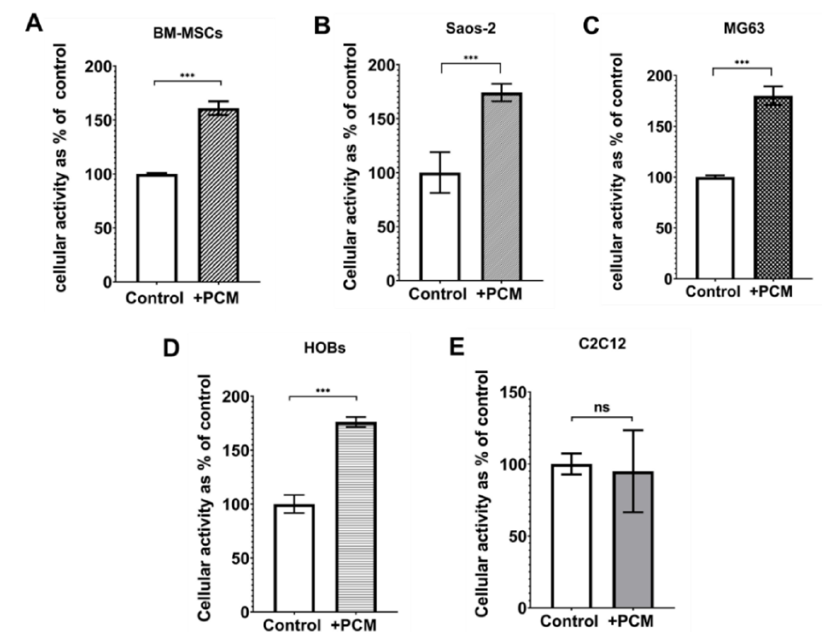
Figure 2. The levels of cell activity in human cells of osteoblastic lineage (MG63 and Saos-2), primary osteoblasts (HOBs), and BM-MSCs cultured with PCM-1000 or CM for 24 h. Cell activity was determined using PrestoBlue cell viability reagent. ( A ) hBM-MSCs, ( B ) Saos-2 cells, ( C ) MG63 cells, ( D ) HOBs, and ( E ) C2C12 cells. Bars indicate the mean level of cellular activity normalised to that of the control cell cultures ( ± SD, n = 3) incubated in CM (values are the means ± SD, n = 3, *** = p ≤ 0.0005, ns = no significant difference between samples).